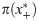
A mixing distribution π(x+*) for the original SVE.The distribution of transition kernels, i.e., π(x+*), for the original SVE algorithm in the Rasch model example with k = 20 items. In this example the average acceptance rate for sampling from the posterior π(θ ∣ x+ = 9) was approximately 37% (see S1 Script).